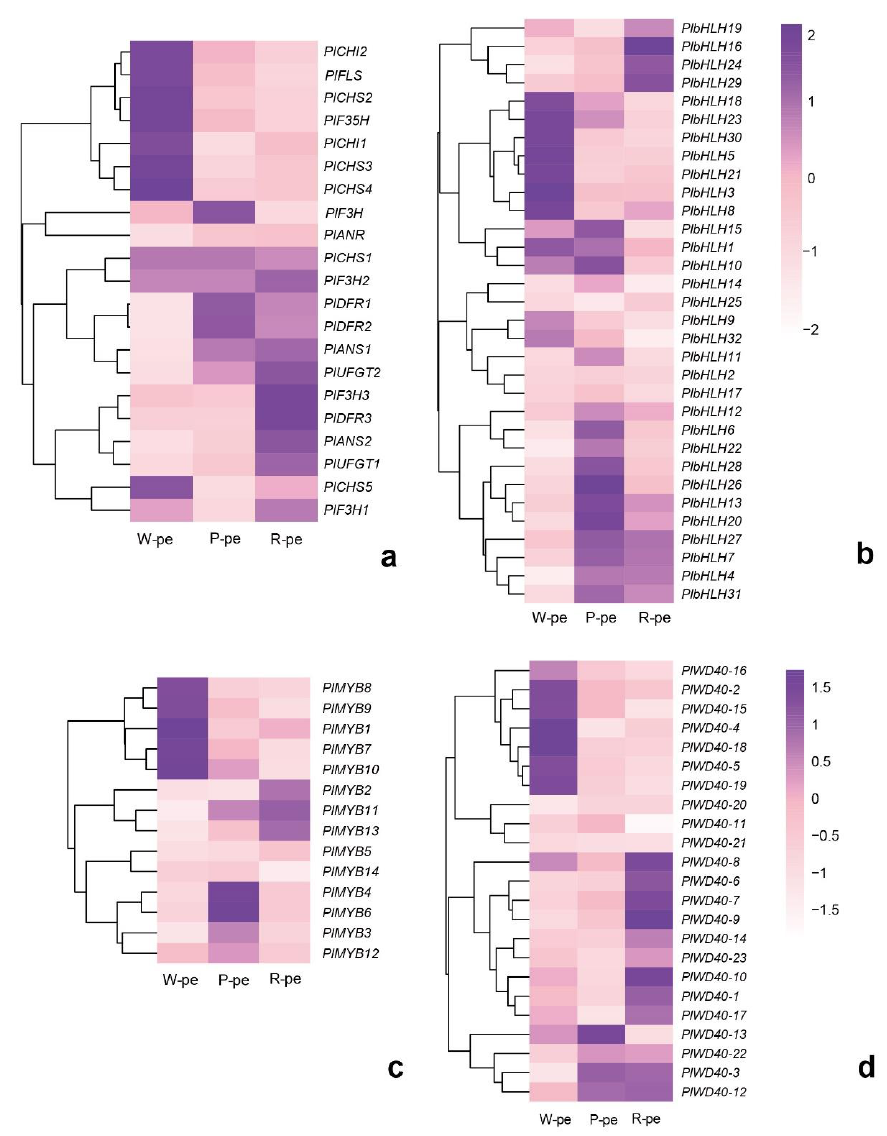
Figure 5. Expression pattern analysis base on RNA sequencing of anthocyanin biosynthesis pathway-related genes and transcription factors in P. limprichtii . ( a ) Anthocyanin biosynthesis pathway-related unigenes; ( b ) bHLH unigenes; ( c ) R2R3-MYB unigenes; ( d ) WD40 unigenes. W-pe (petal of white flower), P-petal (petal of pink flower), R-petal (petal of rose -purple flower).